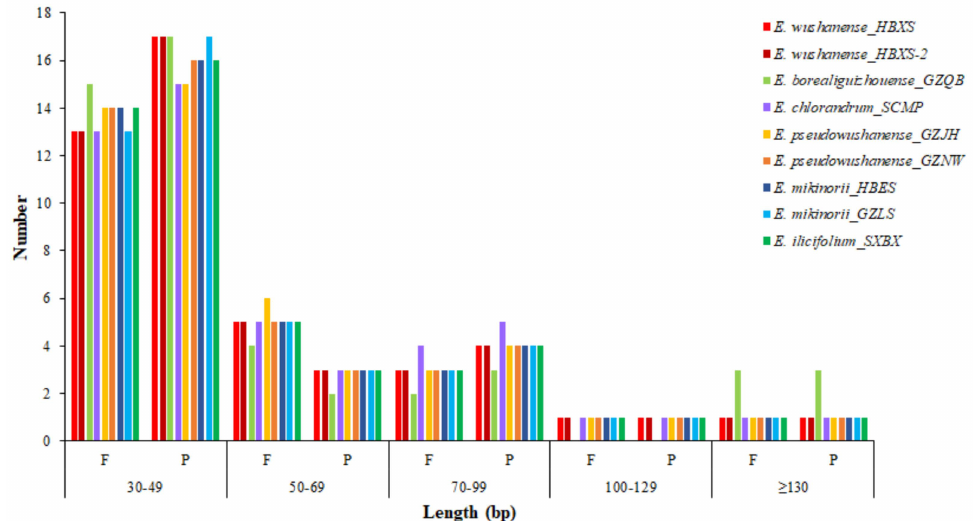
Figure 4. Repeat sequences in the plastid genomes of E. wushanense and its closely related species. F, forward; P,